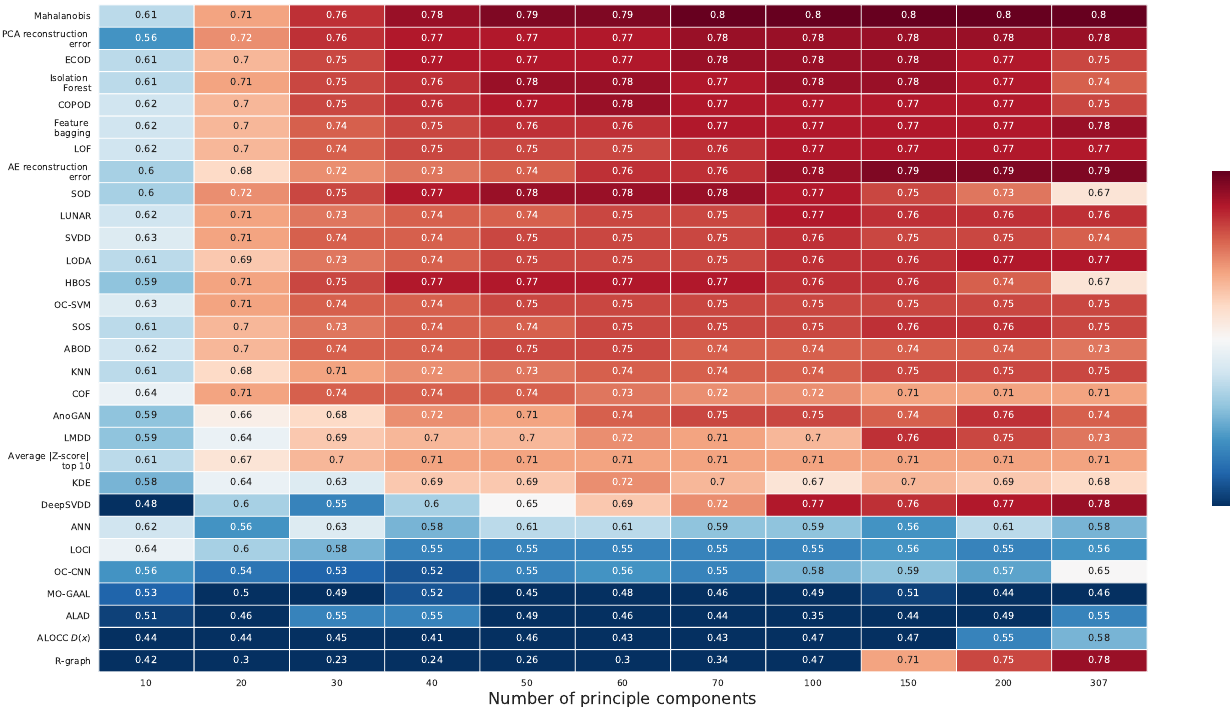
Figure A1. Average AUC (across 4 CVs) for an increasing number of principle components after performing PCA analysis. Hyperparameter settings were fixed for each method (see Table